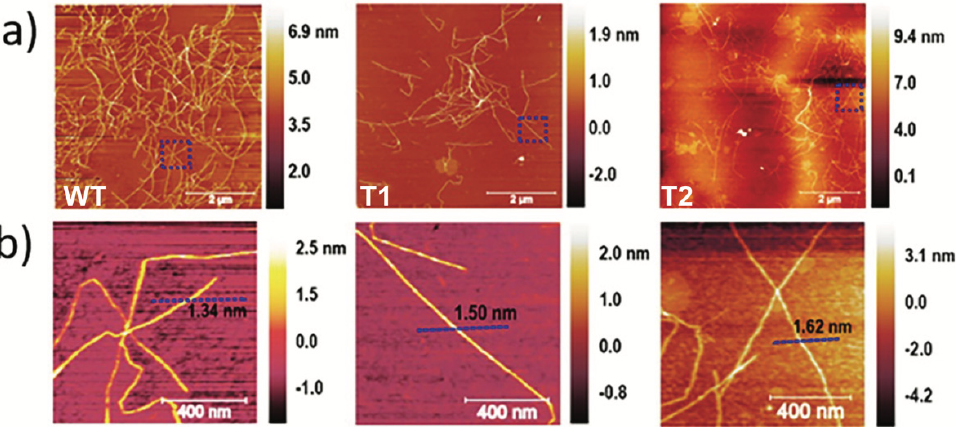
Figure 2. ( a ) Atomic force micrographs of CNFs from WT, T1, and T2. ( b ) Close-up of representative individual nanofibrils and measured height.